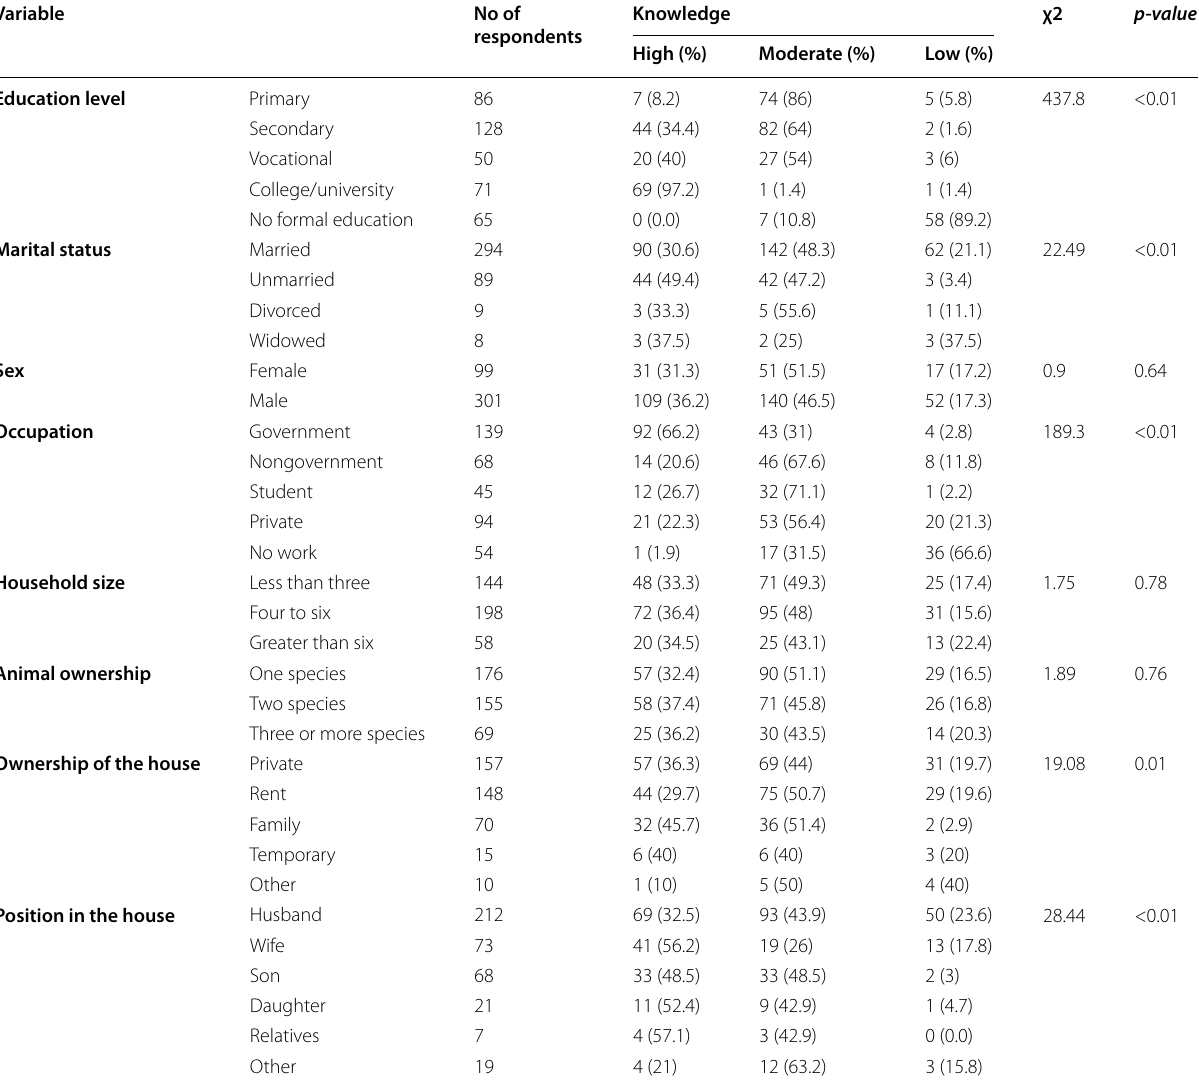
Table 5 Association of knowledge with socio-demographic characteristics